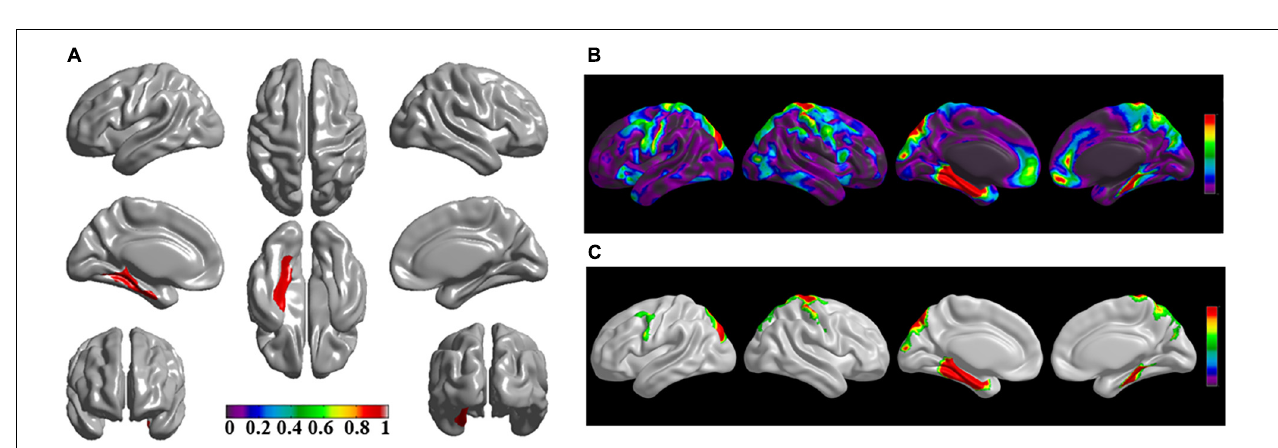
FIGURE 5 | The significantly altered brain regions of cortical structural connectivity in the sPD brain based on seed 5. (A) The brain regions of seed 5, the red brain regions represent the cortical thickness thinning regions. (B) The significantly altered brain regions in the F-map based on seed 5, the red, and green brain regions represent the brain regions of significant cortical structural connectivity alteration that were not corrected by the FWE. (C) The significantly altered brain regions after FWE correction based on seed 5, the red and green brain regions represent the brain regions of significant cortical structural connectivity alteration that were corrected by the FWE.